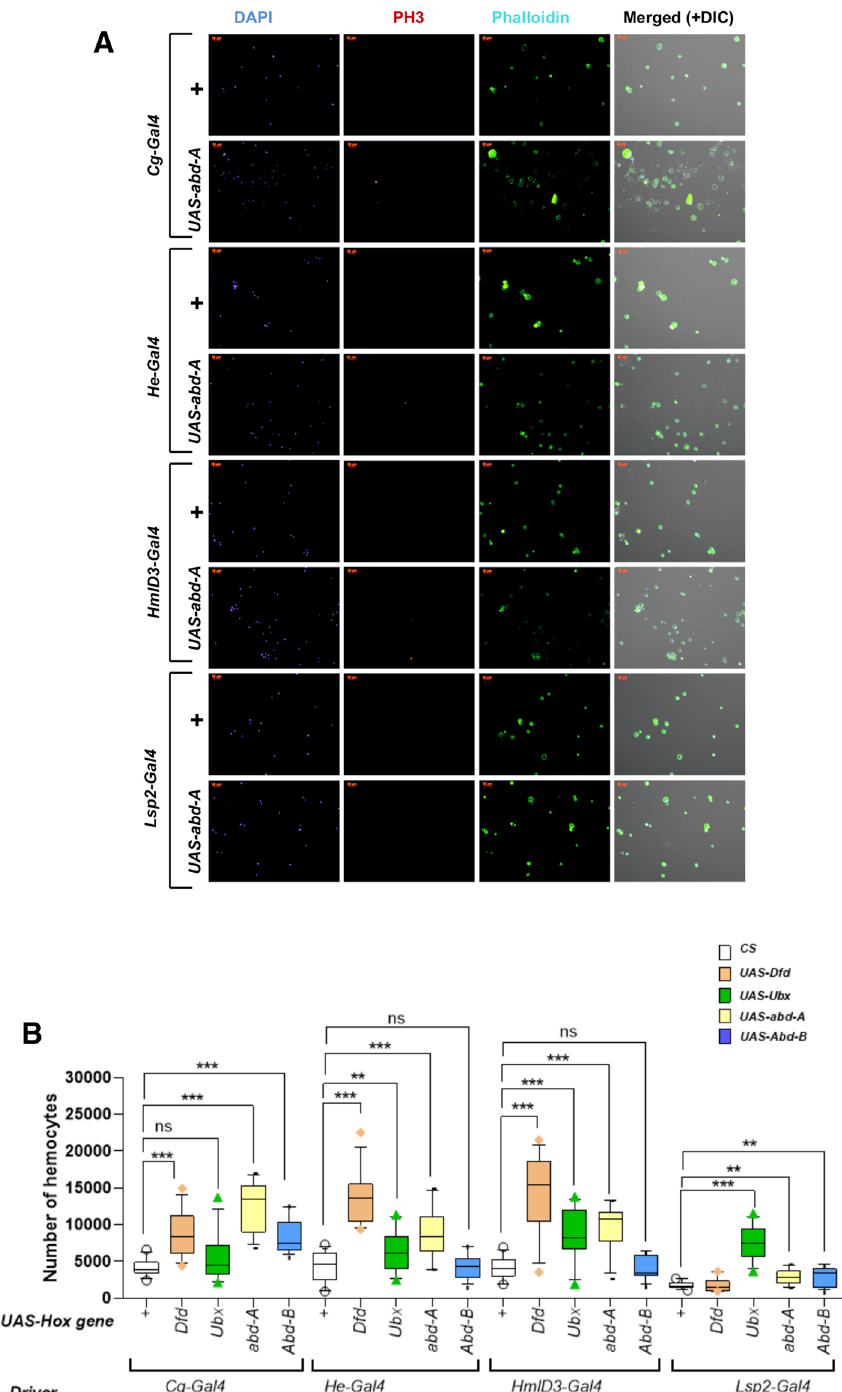
Figure 3. Cell proliferation and quantification of hemocytes. ( A ) Anti-PH3 staining for comparative study of cell proliferation with over-expression of abd-A gene driven by Cg-Gal4, He-Gal4, HmlD 3 -Gal4 and Lsp2-Gal4 . Phalloidin iFluor-488 was used to stain actin filaments. PhosphoHistone3+ nuclei appear when these genes are expressed in the blood cells , indicatin g that some of the increase in cell number maybe due to cell autonomous proliferation. ( B ) The number of circulating hemocytes increases significantly when Dfd is over expressed using Cg-Gal4 ( p = 0.0003), He-Gal4 ( p < 0.0001) and HmlD 3 -Gal4 ( p < 0.0001), Ubx when over expressed with Lsp2-Gal4 ( p < 0.0001) and HmlD 3 -Gal4 ( p = 0.0011), abd-A when over expressed with Cg-Gal4 ( p < 0.0001), Lsp2-Gal4 ( p = 0.0028), He-Gal4 ( p = 0.0018) and HmlD 3 -Gal4 ( p = 0.0002), Abd-B when over expressed with Cg-Gal4 ( p < 0.0001). ( C ) UAS-Dfd, USA-Ubx and UAS-abd-A were over expressed in a HmlD3-Gal4, UAS-GFP background, to test whether overexpression of the genes led to the premature release of cells resident in the cortical zone of the lymph gland. The cortical zones of the over expression larvae appeared to be GFP